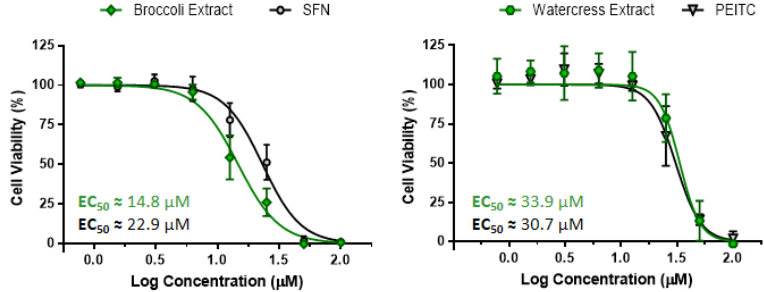
Figure 2. Brassicaceae natural extracts and ITCs exerted antiproliferative effects in a dose-dependent manner after exposition for 24 h. Dose-response profiles of the antiproliferative effect induced by Brassicaceae extracts and respective ITCs in HT29 cell monolayers used as a 2D cell model of CRC. Results are means of three independent experiments performed in triplicate ± SD. Green: Brassicaceae extracts. Black: standard ITCs.